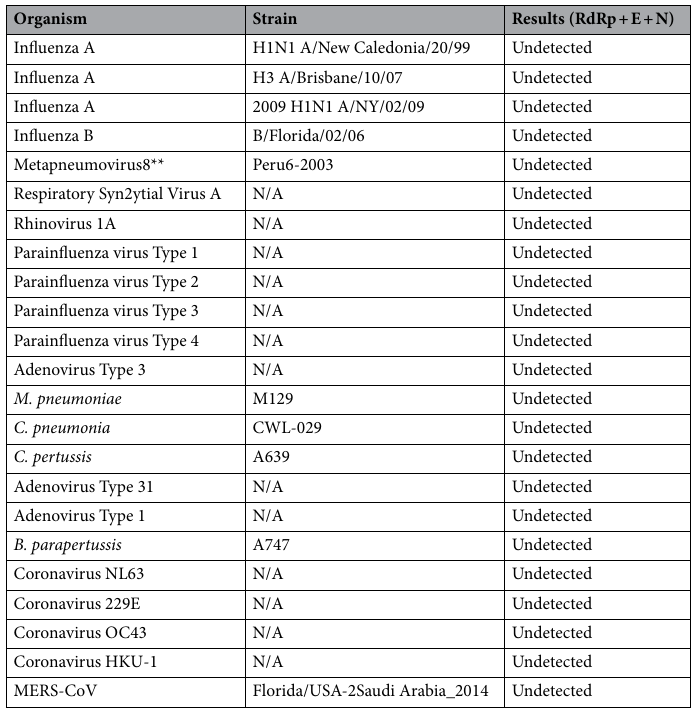
Table 5. Cross reactivity evaluation using NATtrol Respiratory Verification Panel (Catalog Number NATRV2- BIO) and NATtrol MERS-CoV Stock (Catalog Number